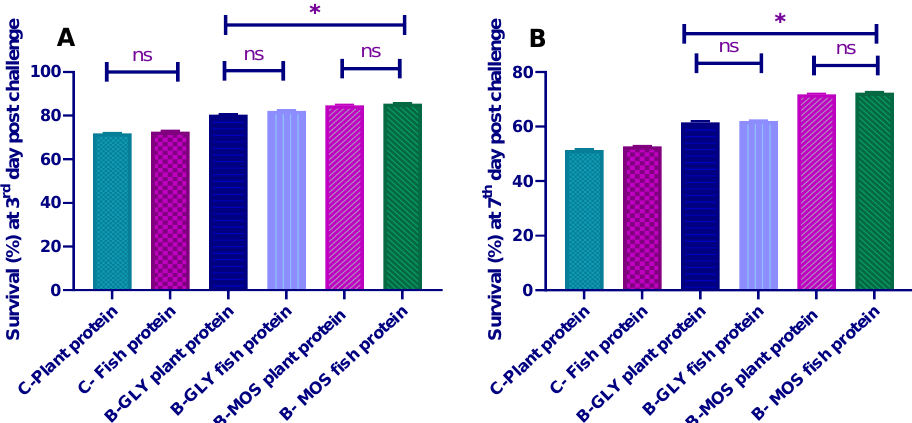
Figure 3. Effect of dietary protein source and carbon source on survival percent at 3 ( A ) and 7 days ( B ) postchallenge in Nile tilapia (data are expressed as mean ± SEM). * Bars with an asterisk correspond to values that are significantly different (Tukey, p < 0.05) ns bars, with ns corresponding to values that are not significantly different.